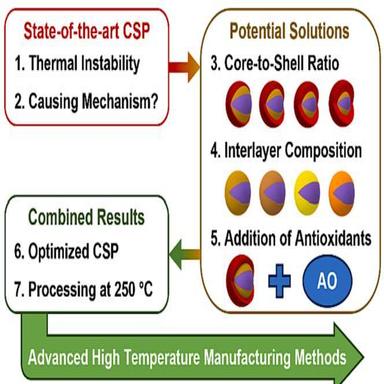
Scheme of the applied strategies in this work. Within the first two chapters, a thermal instability issue was identified, and the underlying mechanism was elucidated. Thereof based solution approaches were tested in the following chapters 3.3 to 3.5. Finally, all solution approaches were combined, to synthesize and process a batch of optimized CSP in chapters 3.6 and 3.7. Advanced optical, thermal, and mechanical properties of the optimized batch are presented in chapter 3.8, thus illustrating application p